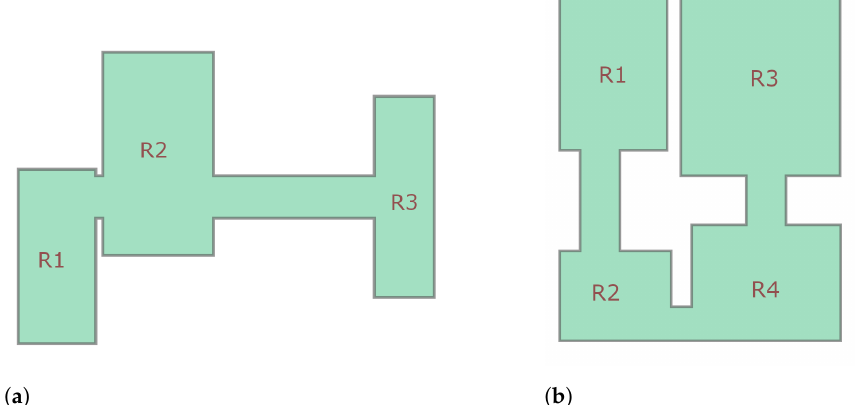
Figure 1. Examples of room-based interior maps. In these maps, the rooms are described by convex polygons, and they are connected by corridors. ( a ) Map A with three rooms and two corridors. ( b ) Map B with four rooms and three